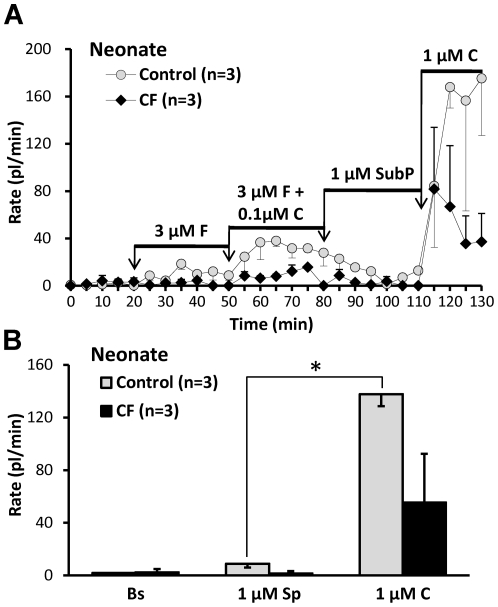
Nasal glands of newborn piglets show minimal secretory response to SubP.
A, Averaged secretion rates as a function of time and stimulation from one day old WT and CF piglets (n = 3 each). Note especially the lack of response to SubP in both groups. B, Data from (A), replotted to show mean basal rates and rates to SubP and carbachol. Mean rates for control (in pl/min/gland) were: basal: 1.8±1.3; SubP: 8.8±2.8; carbachol: 137.7±9.0, (* indicates P<0.0002, n = 3, paired t-test, for difference between responses to SubP and carbachol. Mean rates for CF (in pl/min/gland) were: basal: 2.3±2.5; SubP: 1.5±1.8; carbachol: 55.4±37.0, (n = 3, paired t-test, P = 0.228).